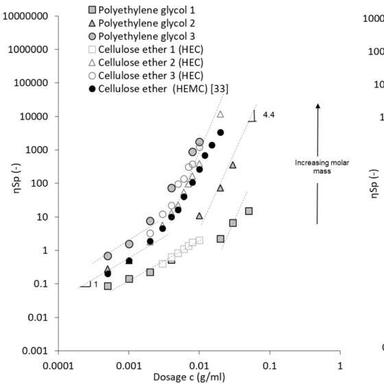
Specific viscosity as a function of (a) polymer dosage (b) c. Adapted from.